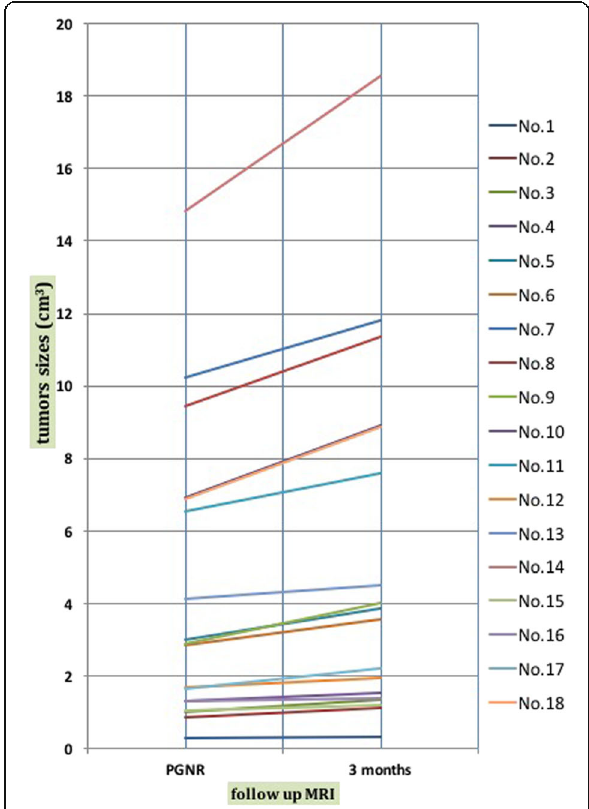
Fig. 3 Linear chart show tumors volumetric changes after 3 months of GNRS